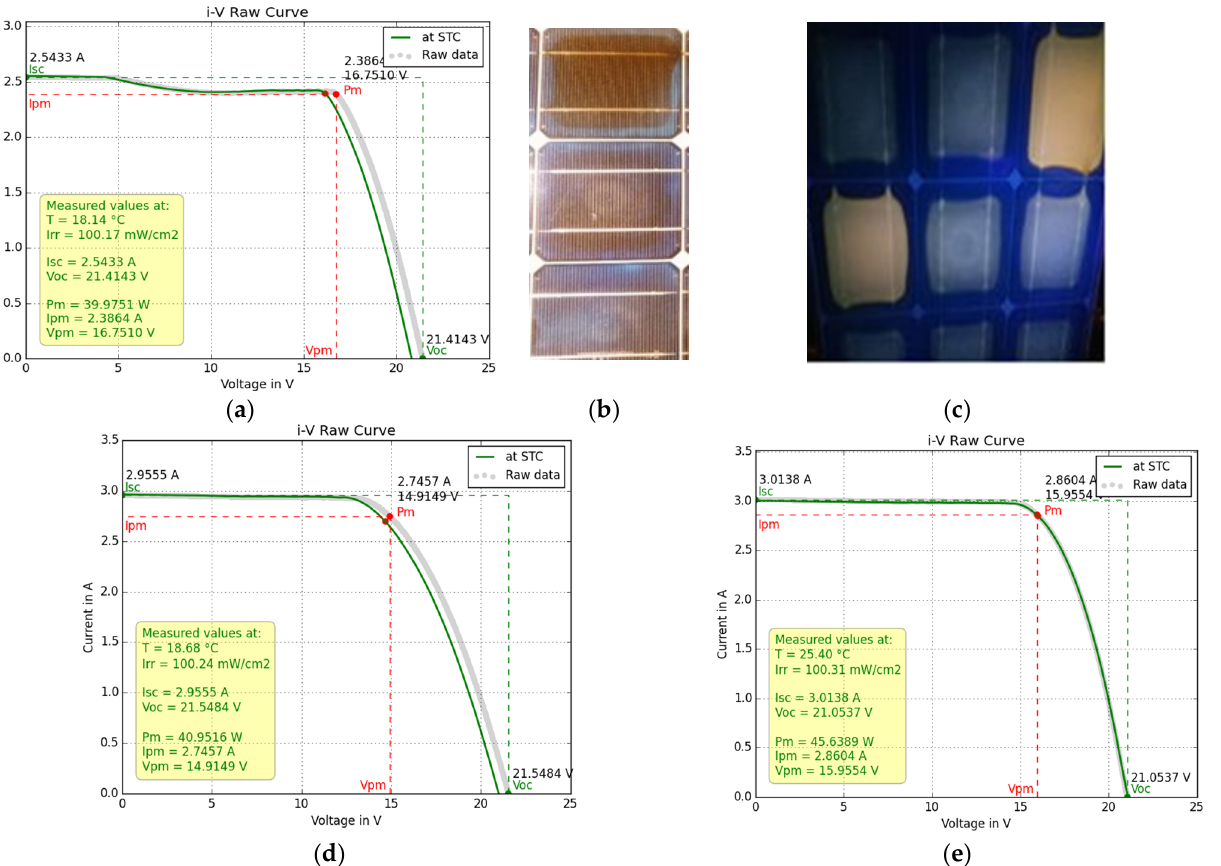
Figure 9. ( a ) I–V characteristic of module no1 captured with the flash tester and converted to STC, ( b ) digital image of the same module showing many cells with severe EVA browning, ( c ) UVF image of same module showing 2 cells with severe EVA browning and neighbouring cells with natural EVA degradation, ( d ) I–V characteristic of M55 module no2, and ( e ) I–V characteristic of SM55 module no3.